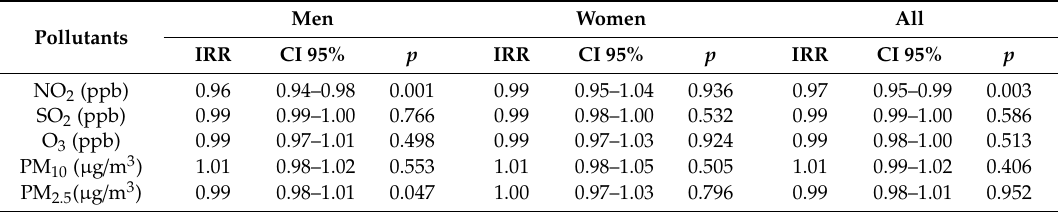
Table 2. Poisson multivariable conditional regression models for daily suicides among men and women in Mexico City, 2000 to